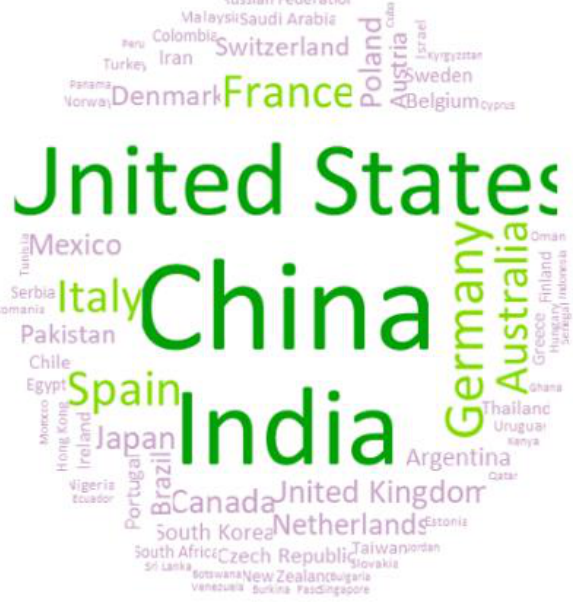
Figure 2. The word cloud chart of the countries. The size of the letters is based on the number of publications per country.